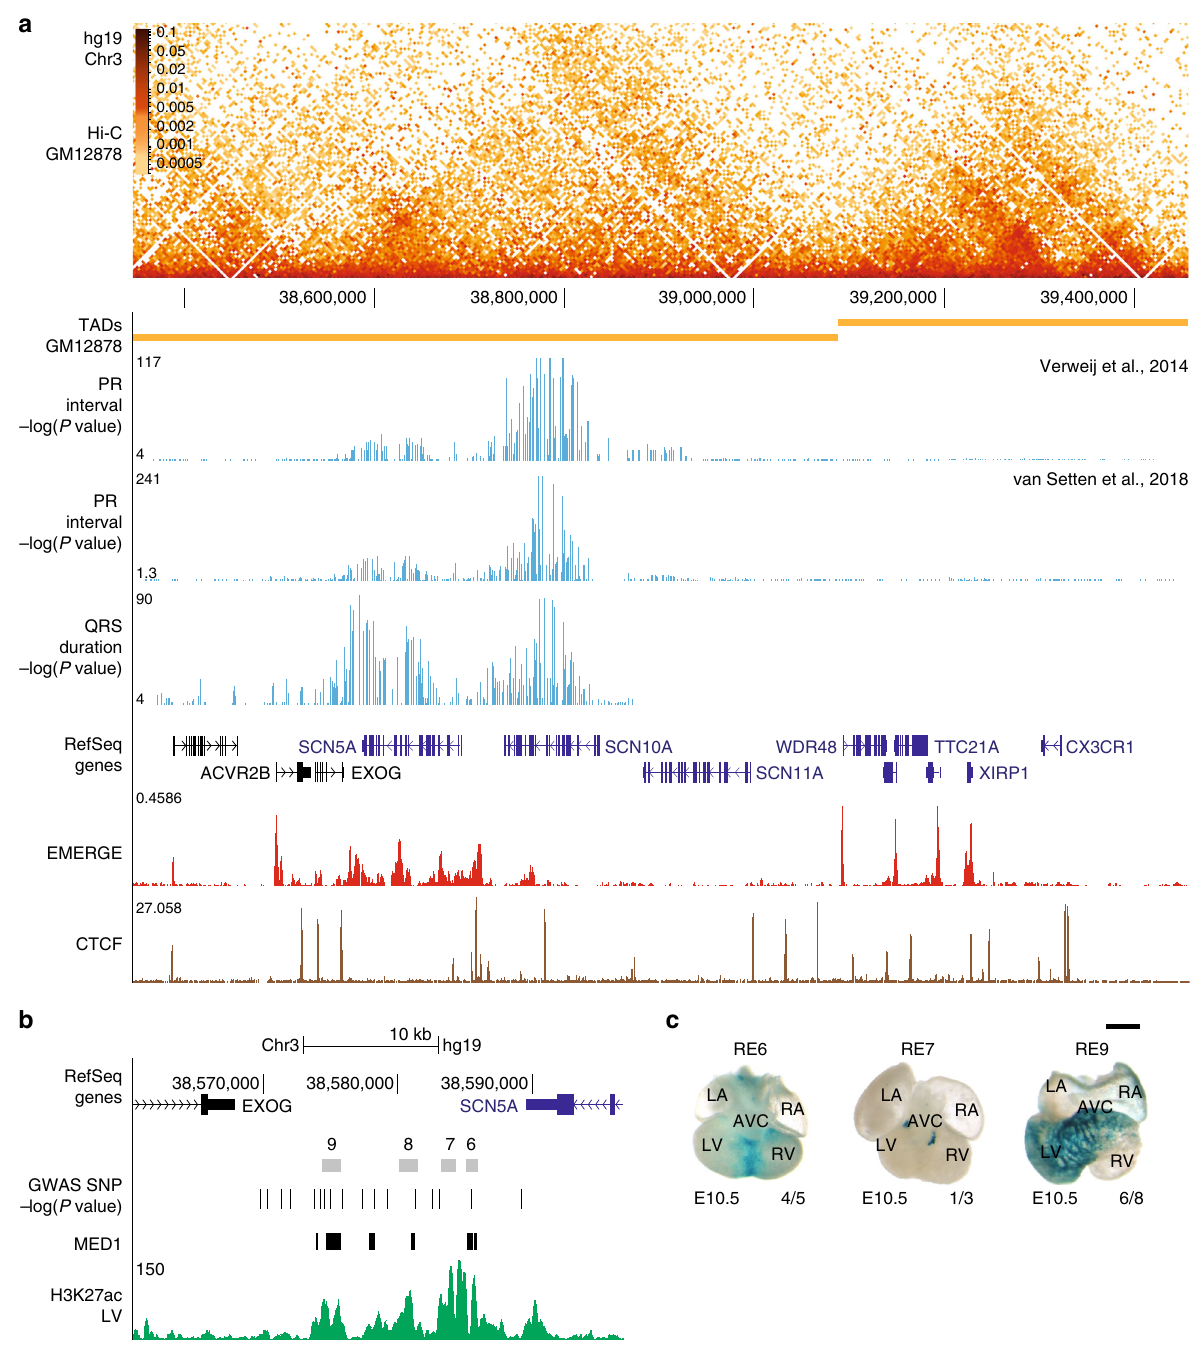
Fig. 1 Identi fi cation of a cardiac-speci fi c, multi-component ‘ super enhancer ’ in the human SCN5A-SCN10A locus. a Hi-C heatmap, visualized using HiGlass, from human lymphobastoid line GM12878 21 of the SCN5A TAD. -log( P values) of the genetic variants associated with PR interval 3,5 and QRS duration 4 , human EMERGE track 29 and CTCF ChIP human cardiac muscle cells are included of the SCN5A-SCN10A locus. b UCSC browser view of the intergenic region between SCN5A and EXOG , composed of four constituent regulatory elements (RE6-9) with “ super enhancer ” characteristics based on human EMERGE, H3K27ac ChIP human left ventricle and Mediator 1 (MED1) ChIP from iPSC-derived cardiomyocytes 32 . PR interval-associated and QRS duration- associated ( – log( P value)) variants are shown in the enhancer cluster. c Dorsal view of E10.5 hearts containing human regulatory elements RE6 4 , 7 and 9 25 in a Hsp68/LacZ enhancer reporter vector. Human RE6 (4/5) is active in the interventricular septum and 9 (6/8) shows in vivo activity in the interventricular septum and left ventricle of embryonic mouse heart. RE7 (1/3) displays only cardiac activity in the embryonic out fl ow tract. Black scale bar is 0.5 mm. LA left atrium, LV left ventricle, RA right atrium, RV right ventricle, AVC anterior ventricular